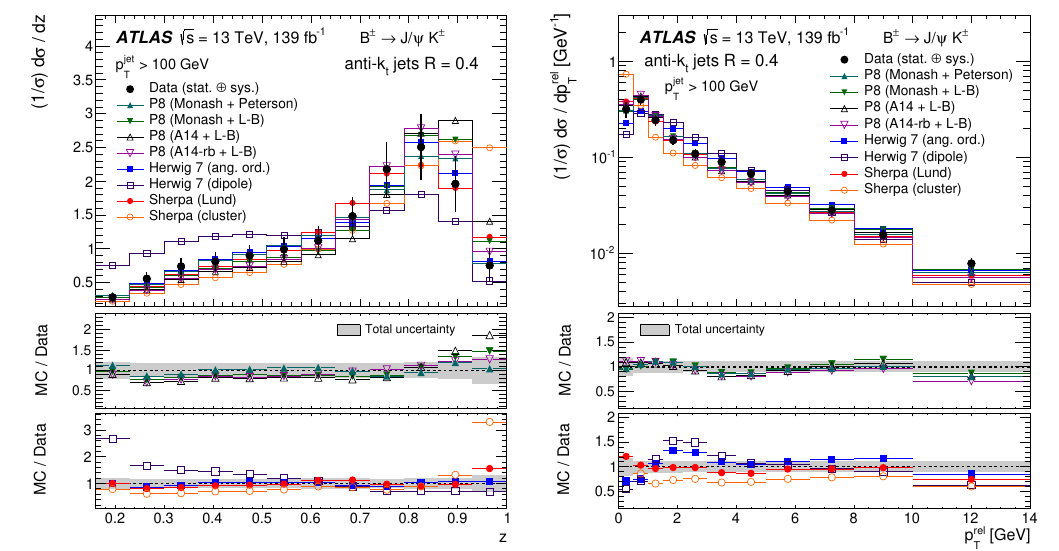
for p 100 GeV, T > T distribution, the prediction T